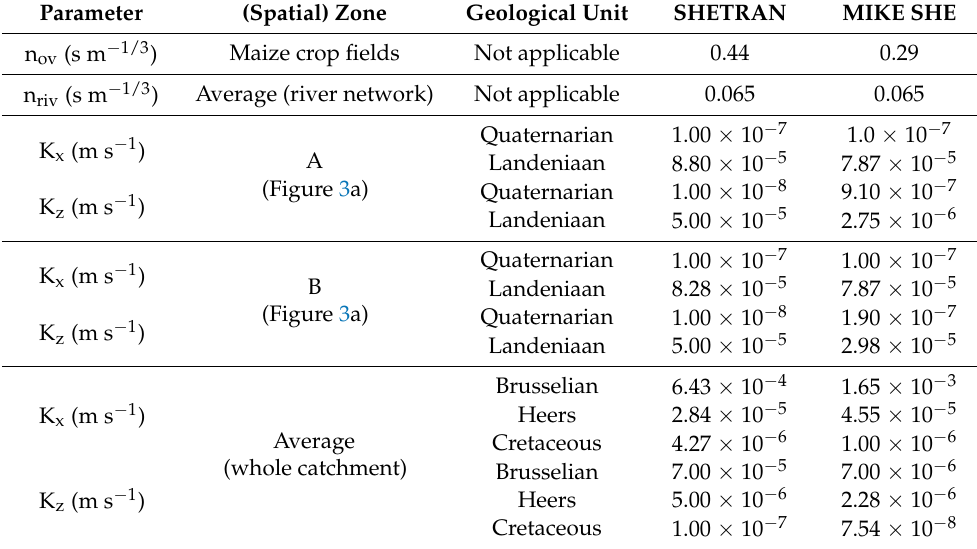
Table 2. Values of the effective (calibrated) model parameters as a function of the hydrological code used in the study. The values are listed for different spatial zones depending on the type of parameter.